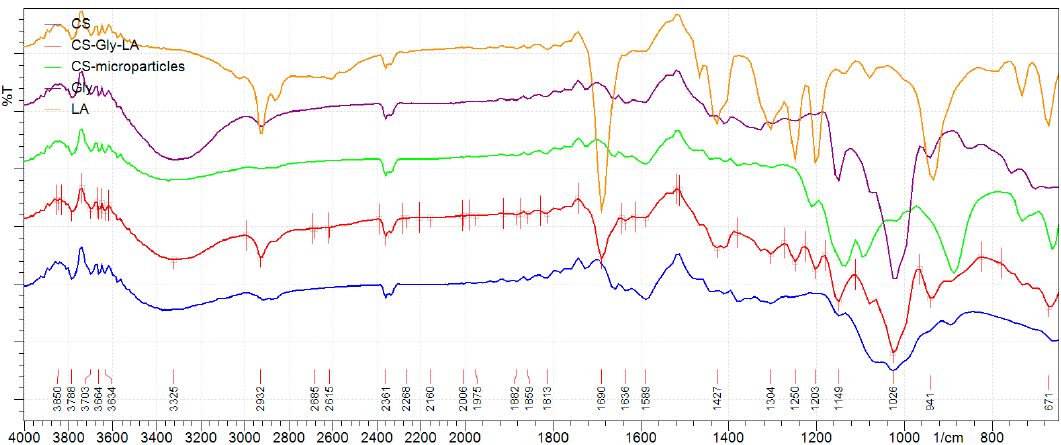
Figure 2. IR spectra of glibenclamide (Gly, pure substance), lipoic acid (LA, pure substance), chitosan